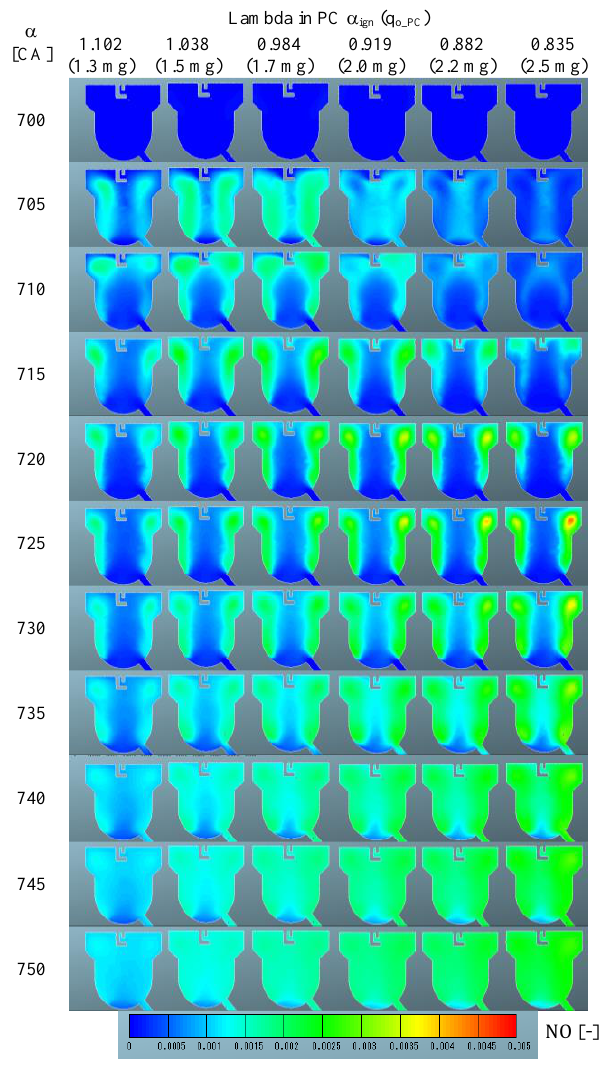
Fig. 16. Impact of the fuel dose fed to the prechamber on the resulting NO mass fraction